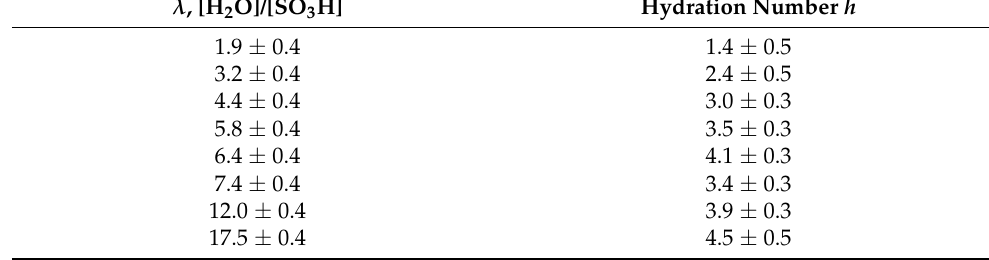
Table 2. Hydration number h at different absolute amounts of water molecules per ionic site SO 3 − ( λ ) in the acidic form of the Nafion 117 membrane. Reprinted with permission from Ref. [41]. Copyright © 2022 Springer-Verlag GmbH Austria, part of Springer Nature. λ , [H 2 O]/[SO 3 H]